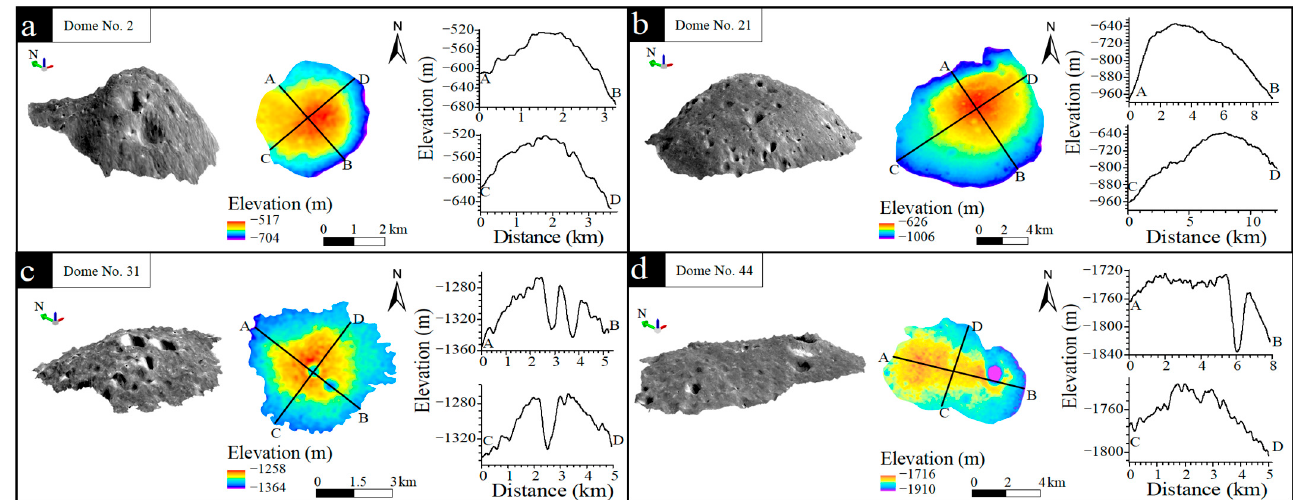
Figure 3. 3D-rendering images, elevation maps and profiles of representative domes. ( a ) Dome no. 2 (35.09°E, 16.51°N) is a typical dome at the eastern edge of the Gardner volcano. ( b ) Domes no. 21 (30.75°E, 14.34°N) and ( c ) no. 31 (32.47°E, 13.88°N) are representative domes to the southwest of the Gardner volcano. ( d ) Dome no. 44 (20.77°E, 9.26°N) is a typical dome in the Mare Tranquillitatis, away from the Gardner volcano. Representative elevation profiles along AB and CD are selected for every single dome. Table 1. Morphological parameters, iron and titanium contents, rheological properties of domes and their dome clusters a . Lon. Lat. No. ( ◦ ) ( ◦